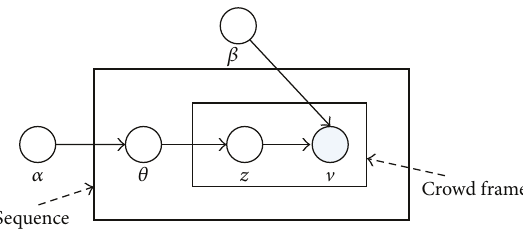
Figure 8: LDA probabilistic graphical